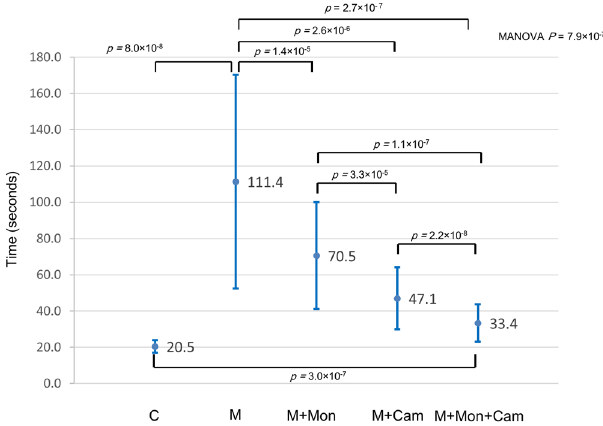
Figure 1. Duration of the modified peg transfer task. Plotting the time (mean ± standard deviation, in seconds) needed to complete the modified peg transfer task for five